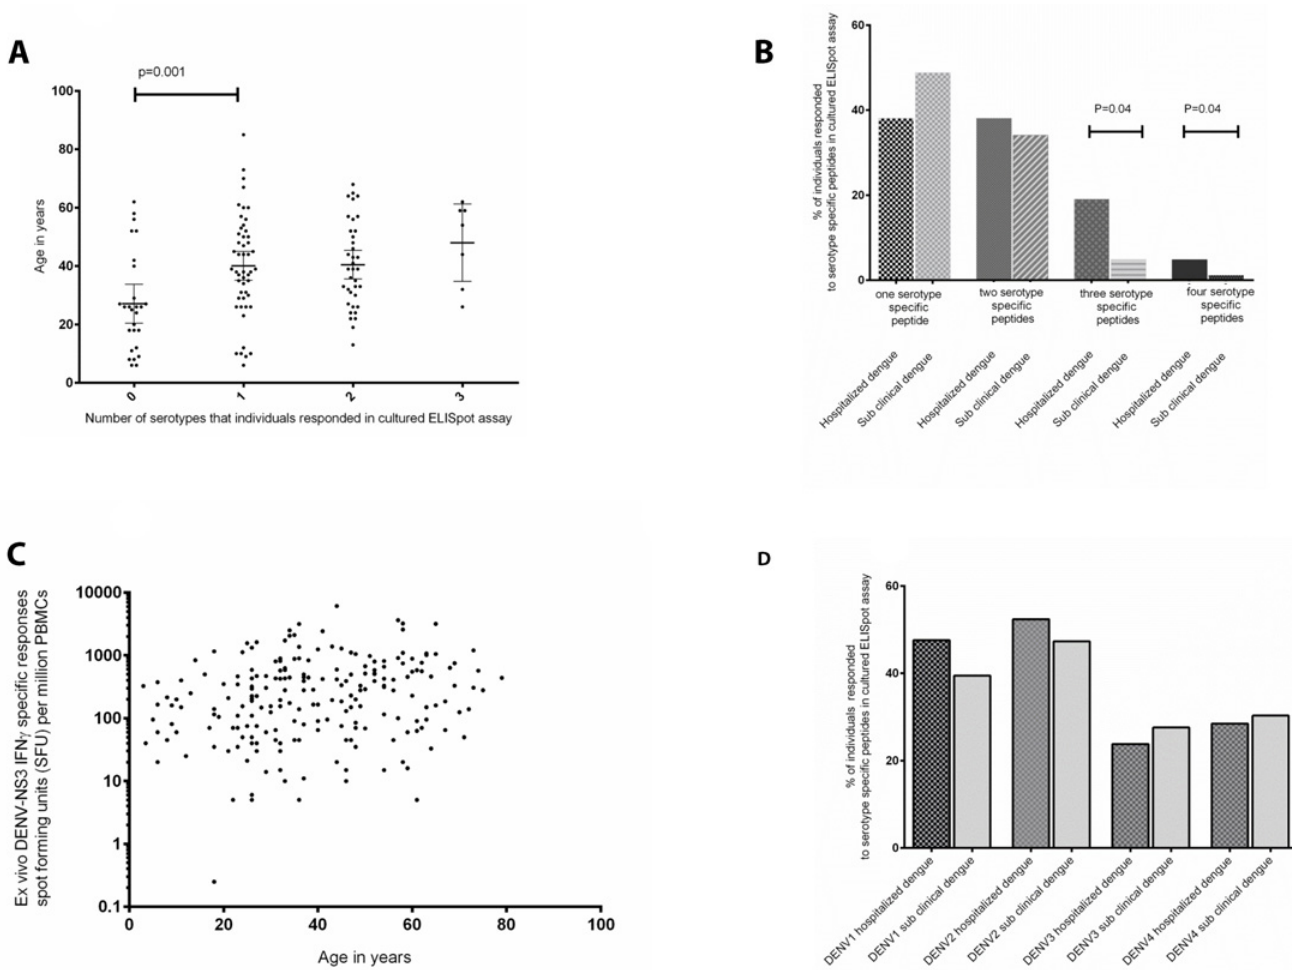
Fig 2. Serotype specific dengue immune responses and disease severity. a) The association of the number of DENV serotypes individual responded to with age of the individual assessed by cultured ELISpot assays. b) The numbers of responses to DENV serotype specific peptides of those who were hospitalized due to dengue and those with past mild/sub clinical dengue infection assessed by cultured ELISpot assays. c) The association of DENV-NS3 specific IFN γ -producing ex vivo T cell responses with age (Spearmans r = 0.05, p = 0.42). d) Percentage of individuals who had been hospitalized due to dengue and those with past mild/sub clinical dengue infection who responded to different serotypes of the DENV assessed by cultured ELISpot